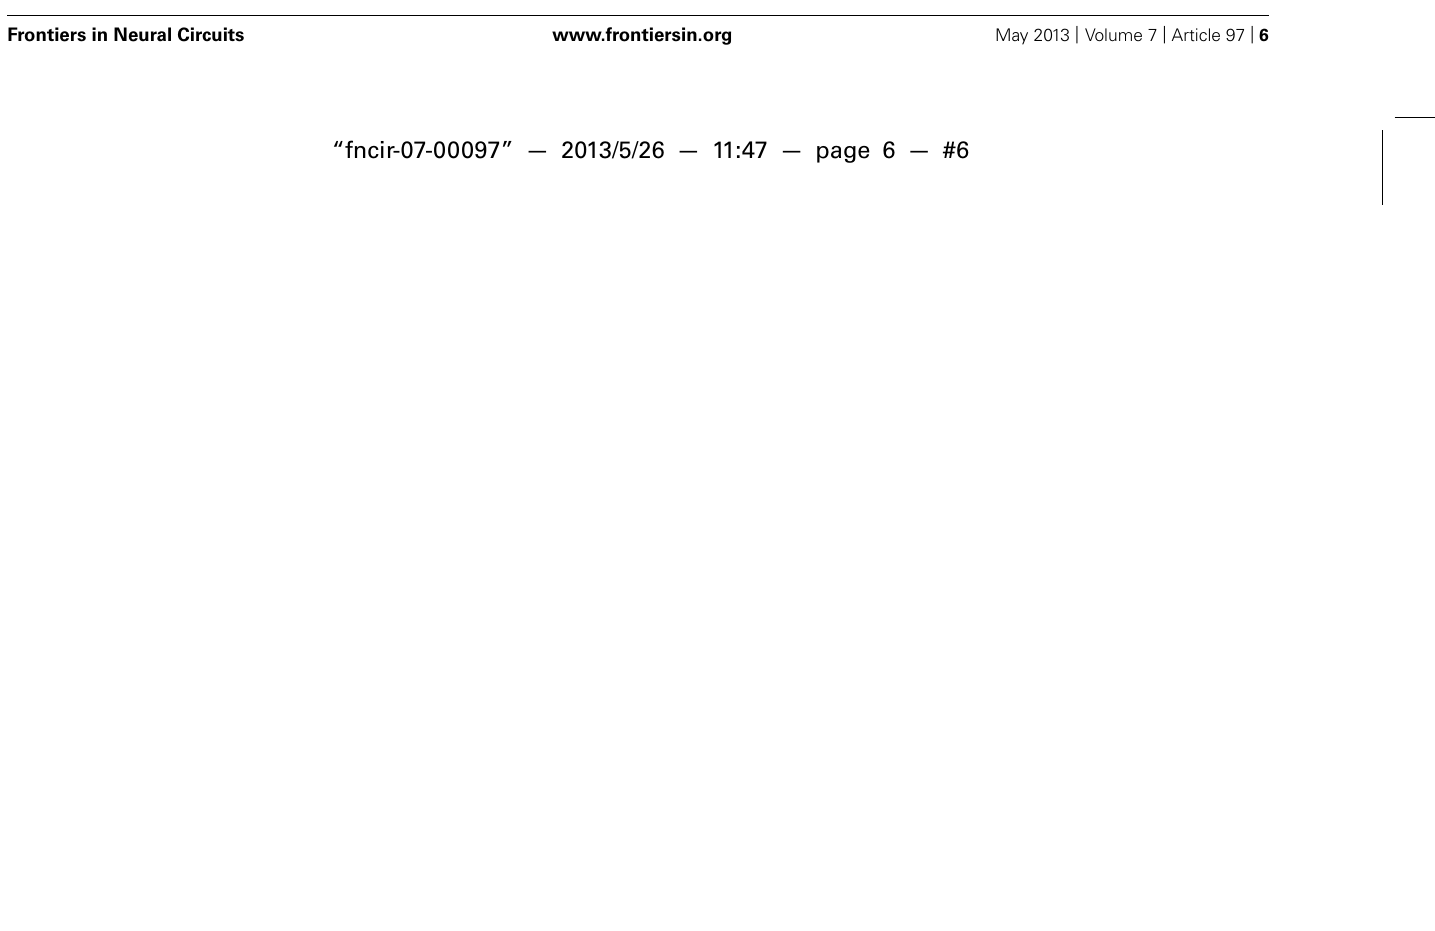
FIGURE 2 | Developmental changes in synapsin (A,D,G), synaptophysin (B,E,H), and the pre-synaptic index (C,F,I) in rat visual (red), somatosensory (green) and frontal (black) cortex. Gray dots are results from all runs, and color dots are the average for each animal. Example bands for each protein and area are shown above the graphs. Exponential decay functions were fit (solid lines), and 95% confidence intervals (dotted lines) were added, adult levels are defined a 3 τ . Synapsin reached adult levels in visual (A) at P37 (3 τ = P37.2 ± 12.6; curve-fit R = 0.70; p < 0.0001), somatosensory (D) at P19 (3 τ = P19.0 ± 14.9; curve-fit R = 0.45; p < 0.005),